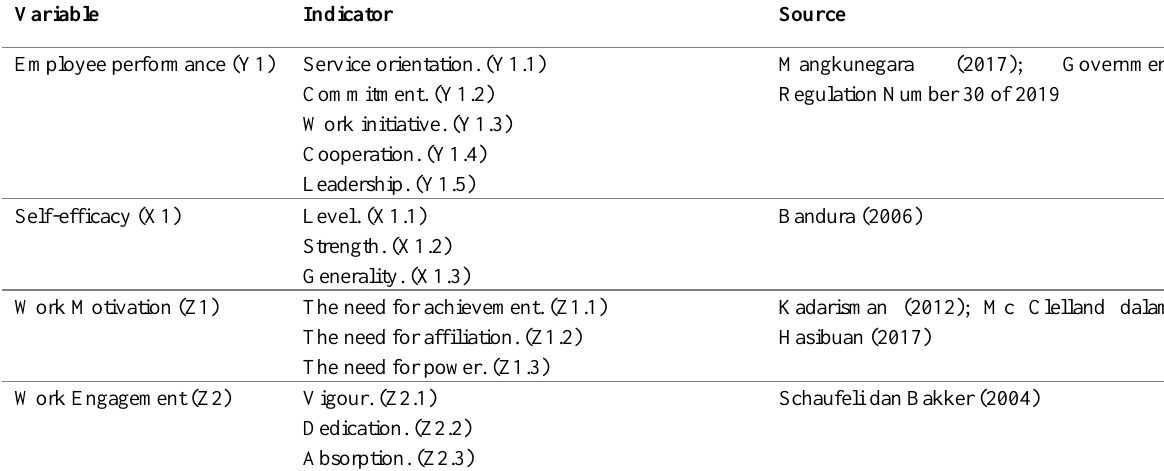
Table 1: Definition of Variable